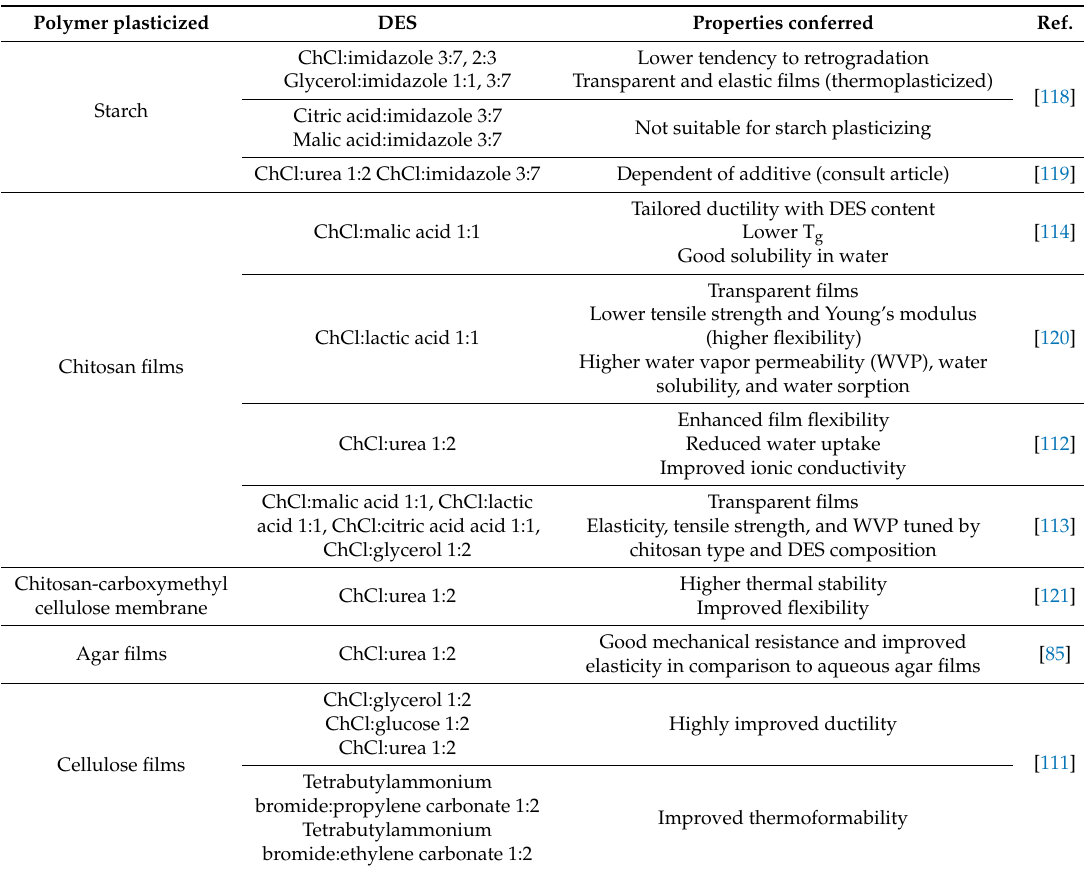
Table 5. Resume of polymer plasticized using deep eutectic solvents and properties acquired by the